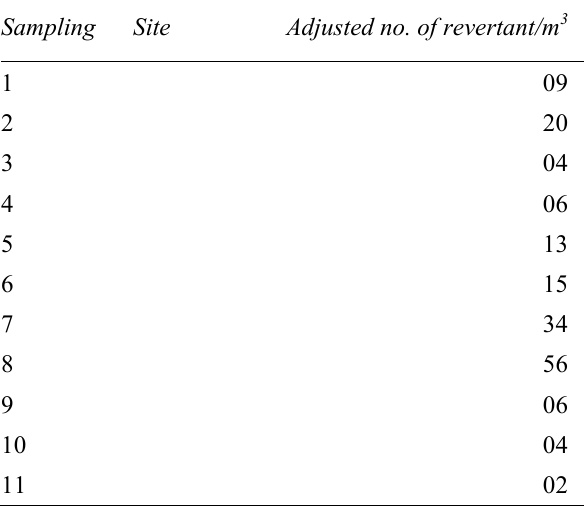
Table 4: Mutagenicity of PM10 extractable organic matter in Salmonella typhimurium (TA98). The plate incorporation assay was conducted with